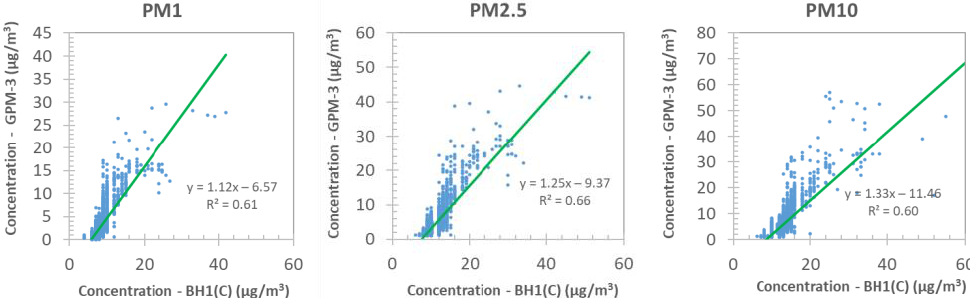
Figure 5. Correlation between the data series of the GPM and BH1 sensors for indoor air monitoring (anteroom) at the urban site, registered between 24 and 30 May 2021 (sampling rate: 1–5 min, n = 7015).